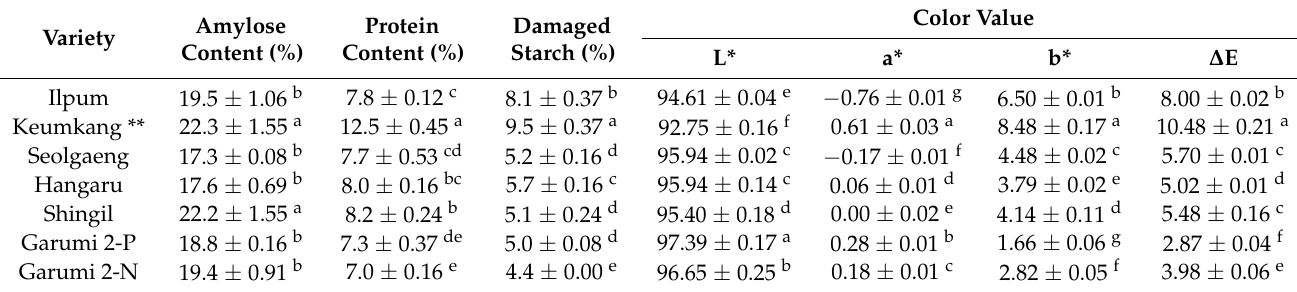
Table 1. Physicochemical characteristics of the flours obtained from different varieties of rice.